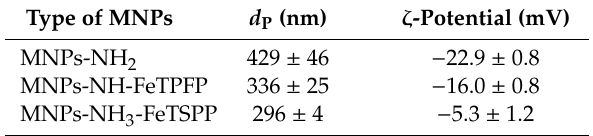
Table 1. Dynamic light scattering (DLS) and ζ -potential data of the modified MNPs.